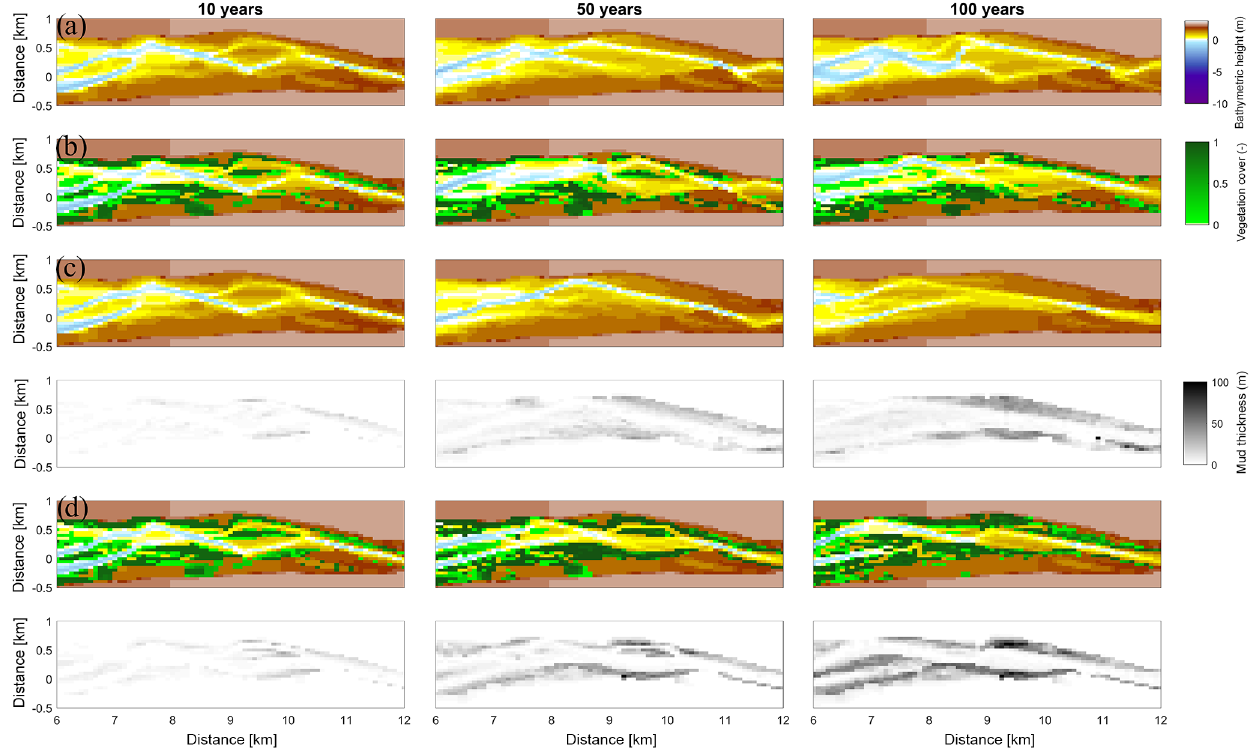
Figure 9. Development of the central zone of the estuary. (a) Simulation without mud and vegetation. (b) Simulation with only vegetation. (c) Simulation with only mud. (d) Simulation with both mud and vegetation. The mud maps belong to the simulation above it.